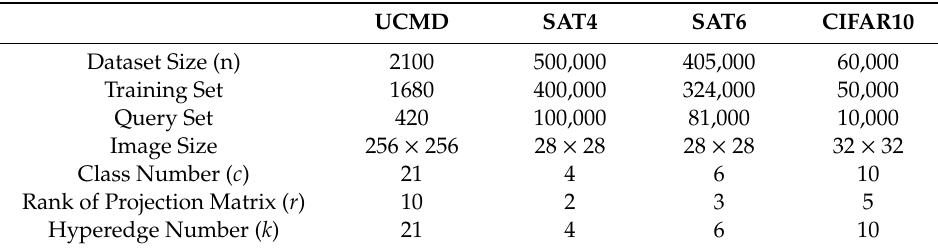
Table 2. Statistics and several parameter settings of four